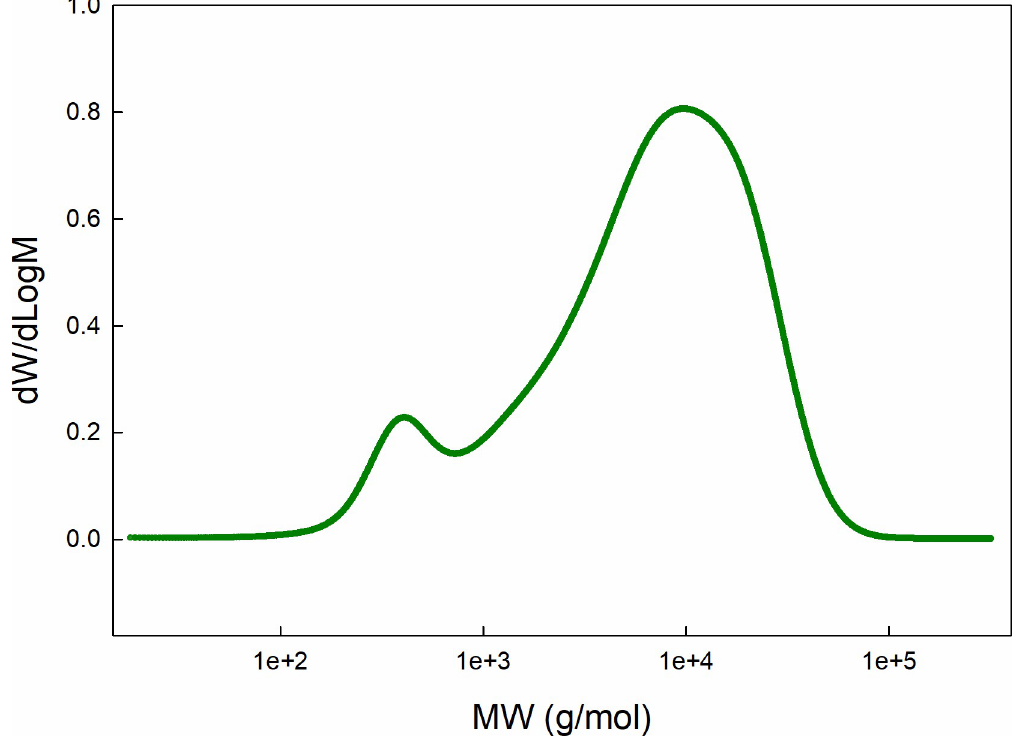
Fig 4. Molecular weight distribution of polysiloxanes produced via protocol 1. Ring-opening polymerization following “protocol 1” produced polysilioxanes with bimodal distribution. These two peaks can be separated by distillation under reduced pressure with a high molecular weight peak (Mp ~ 9,400 g/mol) and a low molecular weight peak (Mp ~ 300 g/mol). The low molecular weight fraction contains a higher concentration of fluorinated monomers estimated by 1 H-NMR and is capable of dissolving the fluorinated surfactants. Peak 1 corresponds to the higher molecular weight peak (rightmost) and peak 2 corresponds to the lower molecular weight peak (leftmost). S4 Fig in S3 File. shows an overlay of two gel permeation chromatography runs of the two distinctive fractions separated by